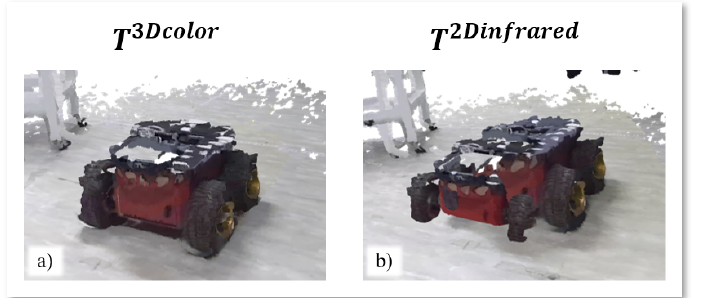
Figure 9. Visual representation of the ( a ) best ( T 3 Dcolor ) and ( b ) worst ( T 2 Dinfrared ) alignment of point cloud in color geometry P color . The input point clouds are captured at the same timestamp from both the Azure Kinect